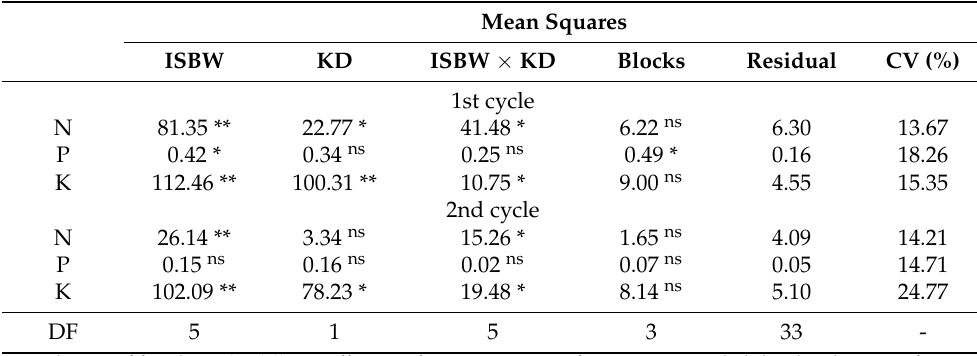
Table 1. Summary of the analysis of variance referring to the leaf concentrations of nitrogen (N), phosphorus (P), and potassium (K) in Passiflora edulis Sims under brackish water irrigation strategies (ISBW) and potassium fertilization (KD). Mean Squares ISBW KD ISBW × KD Blocks Residual CV (%) 1st cycle N 81.35 **